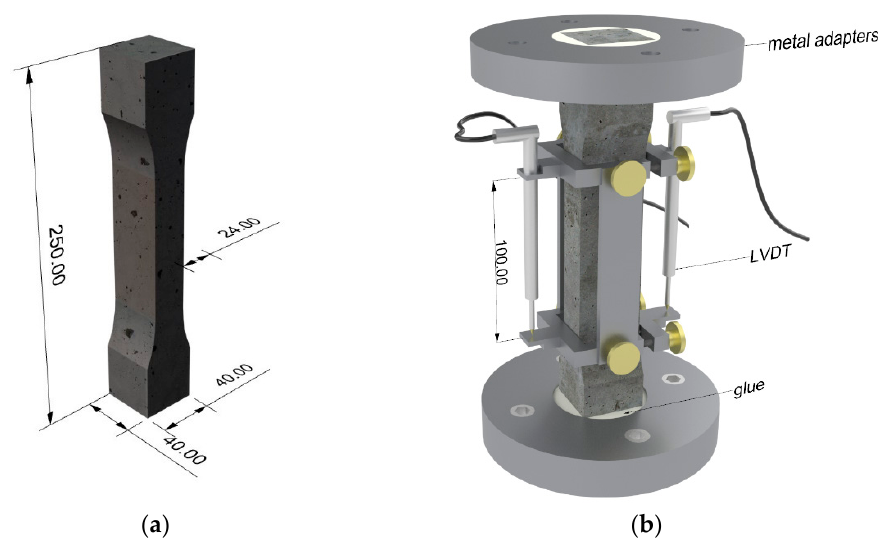
Figure 3. Macro-mechanical cyclic tests: ( a ) dumbbell-shaped specimen; ( b ) experimental setup.